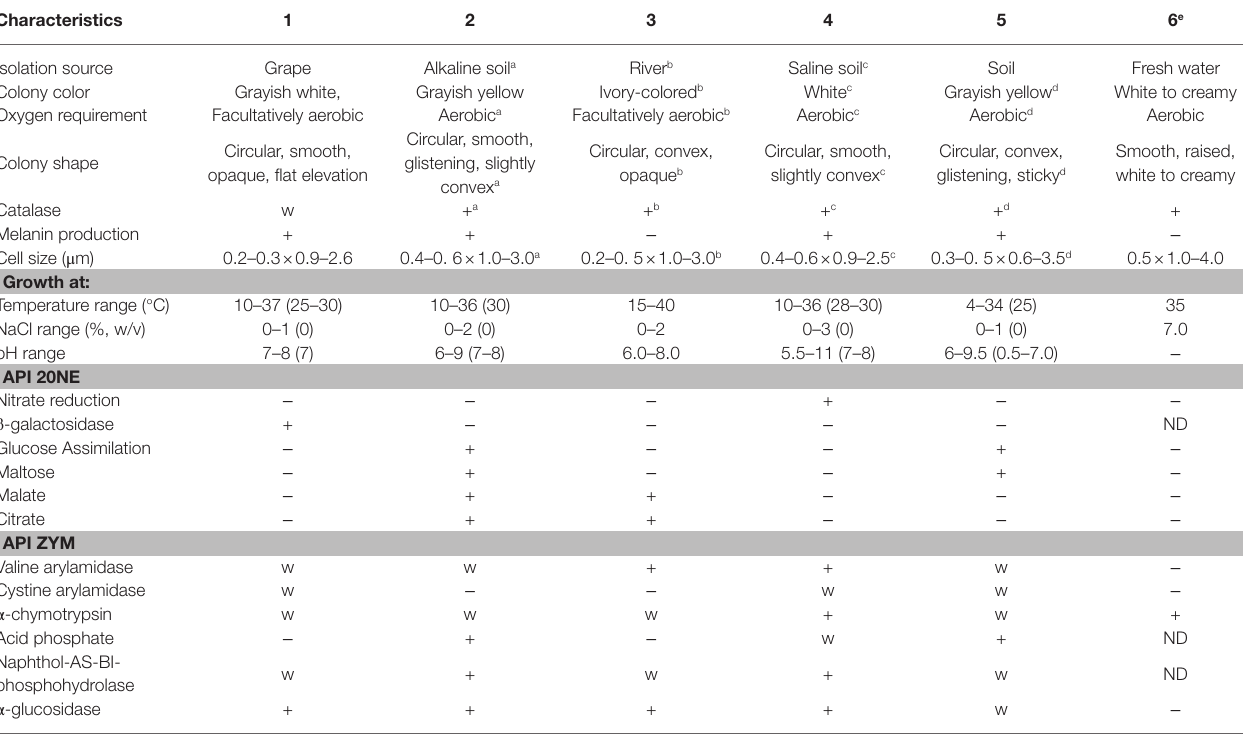
TABLE 1 | Differential physiological and biochemical comparison of strain GR-TSA-9 T and closely related type strains.